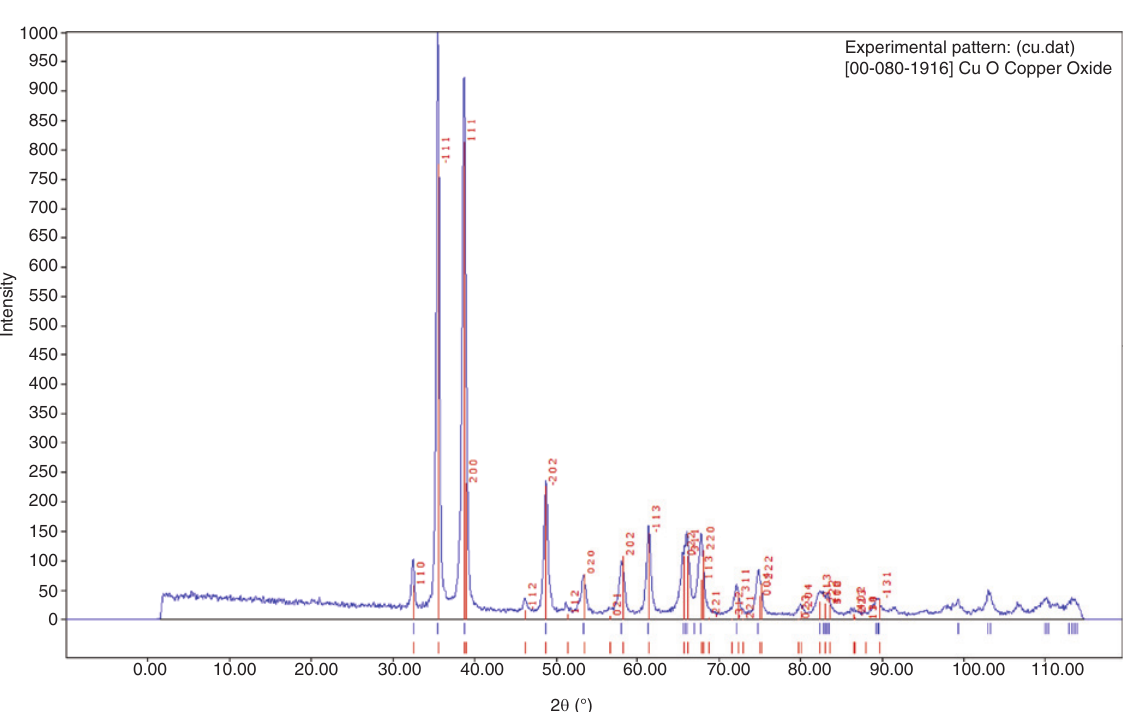
Figure 5: XRD pattern of synthesized copper